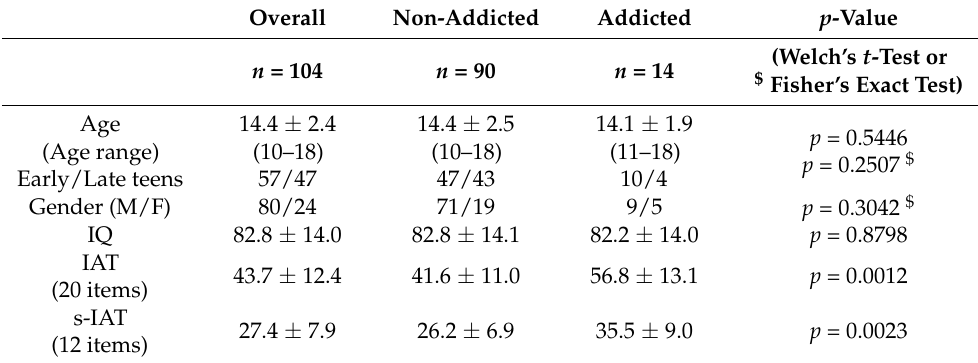
Table 1. Sociodemographic information and scores of the IAT/s-IAT of the